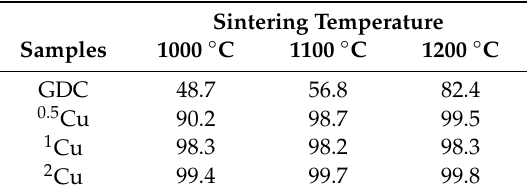
Table 3. Density values of sintered bodies.